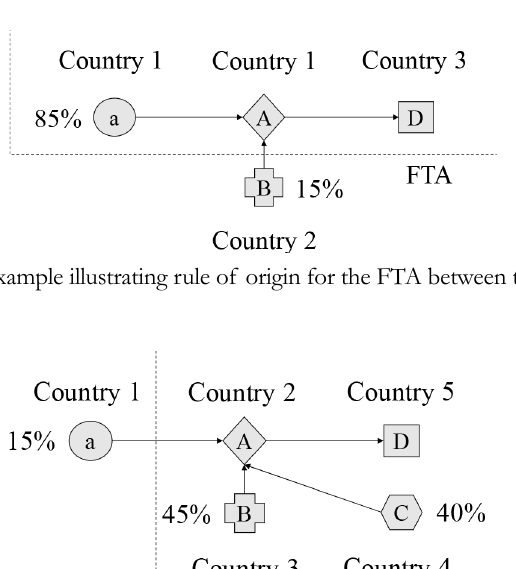
Figure 1. An example illustrating FTA